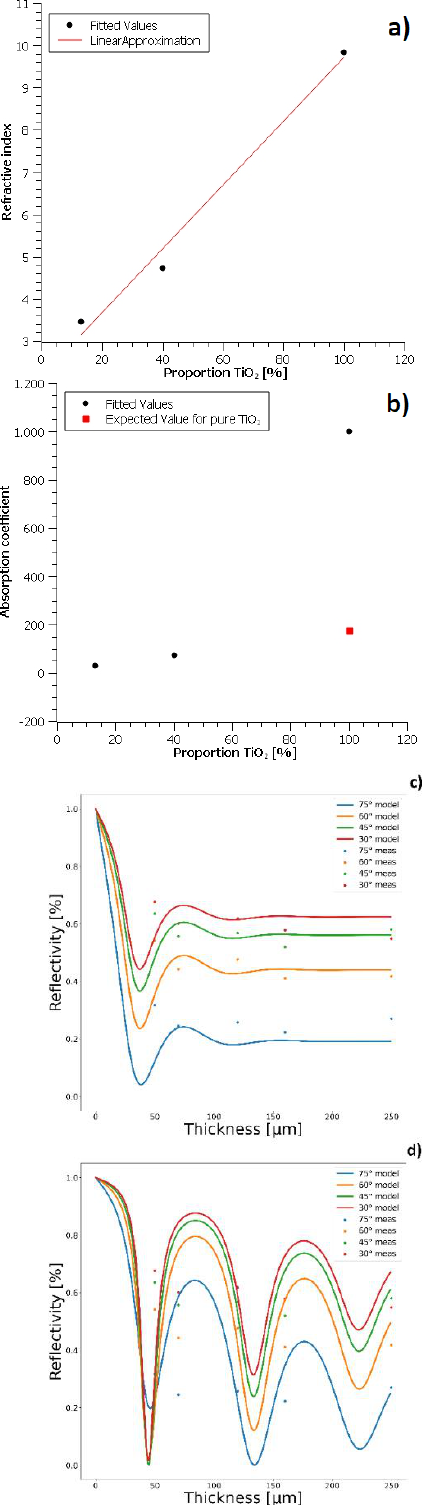
Fig. 6. The effect of an increase in TiO 2 proportion on the refractive index (a) and absorption coefficient (b). In red the linear fit and the expected value from a linear fit respectively is shown. In (c) and (d), the resulting thickness dependency for pure TiO 2 is shown, when considering an absorption coefficient of 1000S/m (c) and one of 175S/m